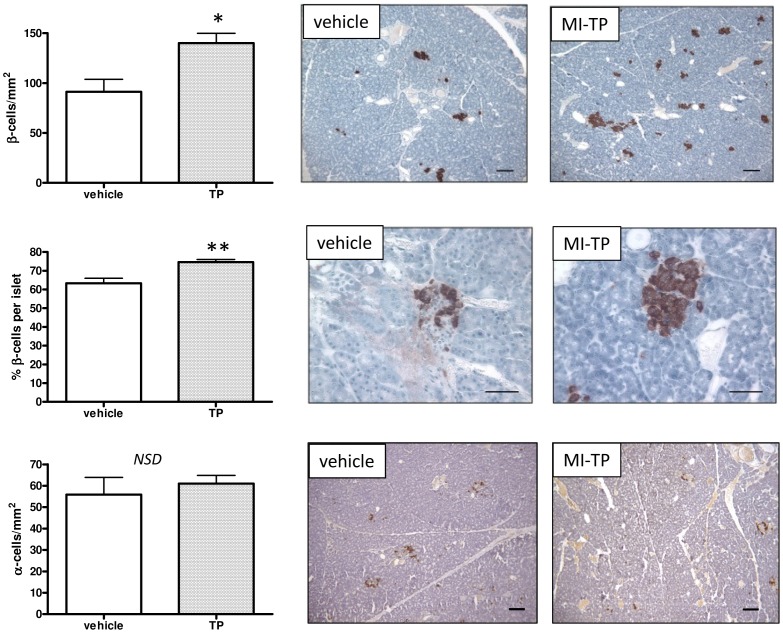
The effect of TP administration on adult endocrine pancreas.Female adult α- and β-cell content from vehicle and MI-TP treated pregnancies was assessed by immunohistochemistry. Prenatal TP treatment was associated with significantly increased total β-cell numbers at 11 months postnatal age in MI-TP offspring (n = 8) (P<0.05), which in turn was associated with increased numbers of β-cells per islet (P<0.01), as compared to vehicle treated offspring (n = 5). There were no effects of prenatal treatment as regards α-cell content. Photomicrographs are representative sections of adult pancreas from vehicle and MI-TP treated pregnancies (scale bars represent 50 µm).